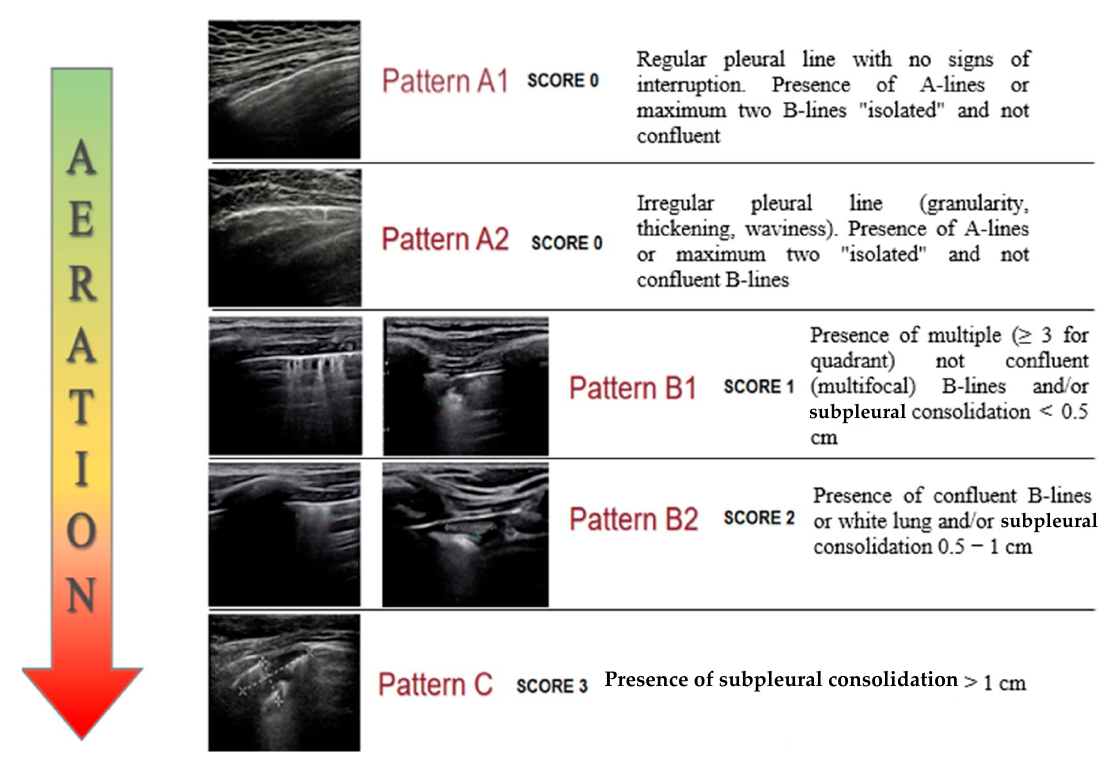
Figure 2. Lung ultrasound patterns with the degree of pulmonary aeration.